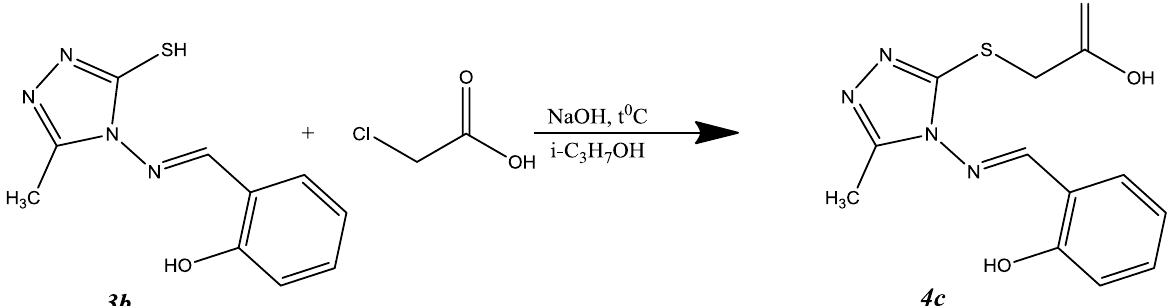
Fig. 4. Scheme of synthesis of 2-((4- (2-hydroxybenzylideneamino) -5-methyl-4H-1,2,4-triazol-3-yl) thio) acetic acid ( 4c